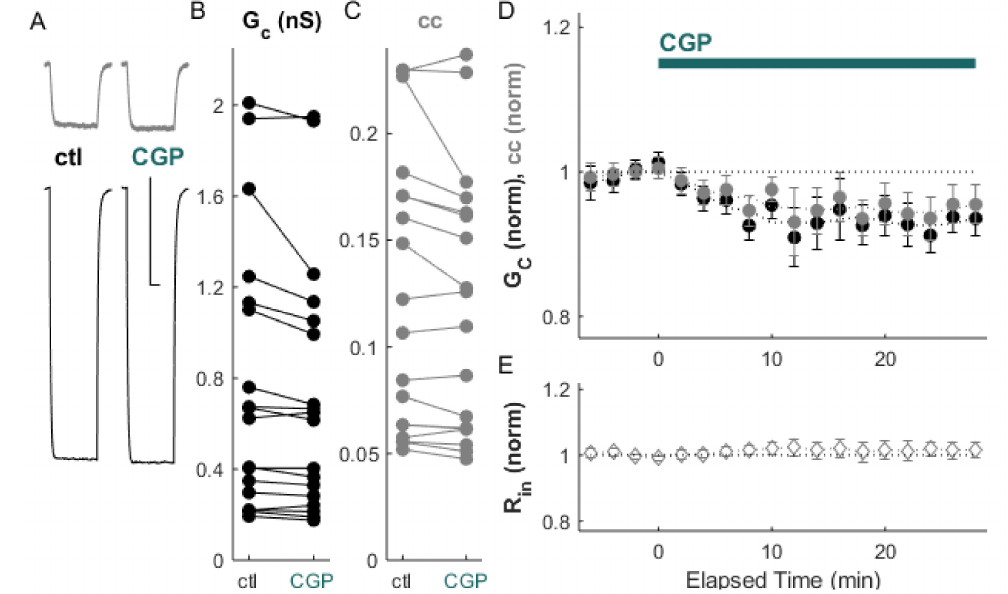
Figure 1. Coupling is depressed by the GABA B antagonist CGP. ( A ) Example of paired recordings of electrically coupled neurons, in response to a − 100 pA step to one neuron (bottom trace), before (ctl) and after bath CGP application. Scale bar 100 ms, 5 mV for both neurons. ( B ) Conductance G C and ( C ) coupling coefficients cc for the cohort of pairs used in this experiment. ( D ) After CGP application, ∆ G C (black) was − 6.1 ± 0.5%, p w = 0.005, and ∆ cc (grey) was − 4.6 ± 0.6% relative